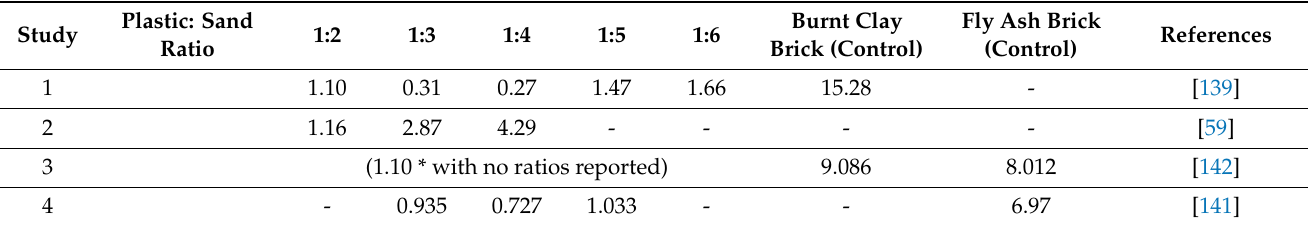
Table 2. Comparison of water absorption (%) of various experimental studies that manufactured plastic sand